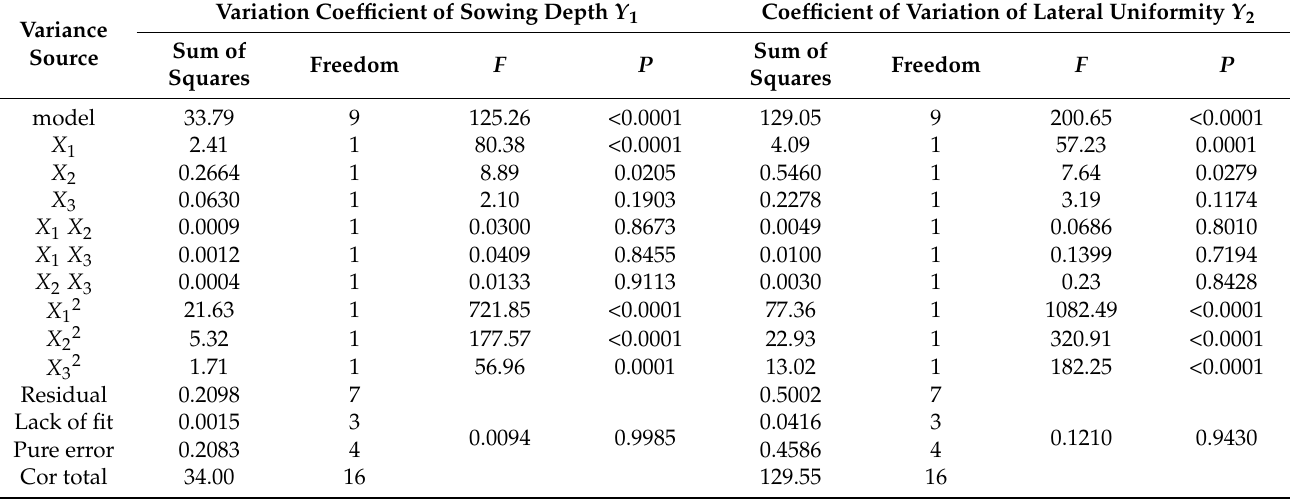
Table 5. Variance analysis of regression